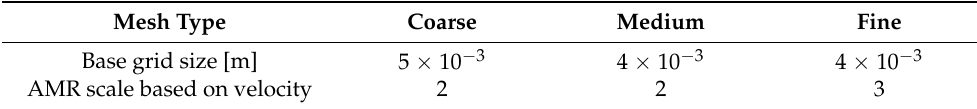
Table 2. Main mesh properties for grid independency analysis. Mesh